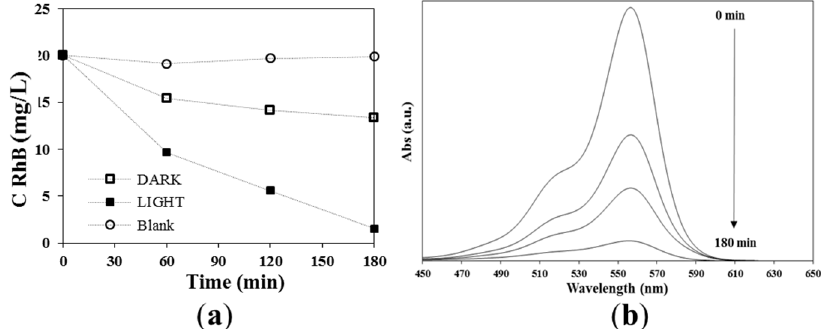
Figure 8. ( a ) Change in the concentration of Rhodamine B (RhB) at different conditions; ( b ) change in the absorption spectra of RhB during its photodegradation in the presence of Cs 3 Bi 2 I 9 nanoparticles under visible-light irradiation.